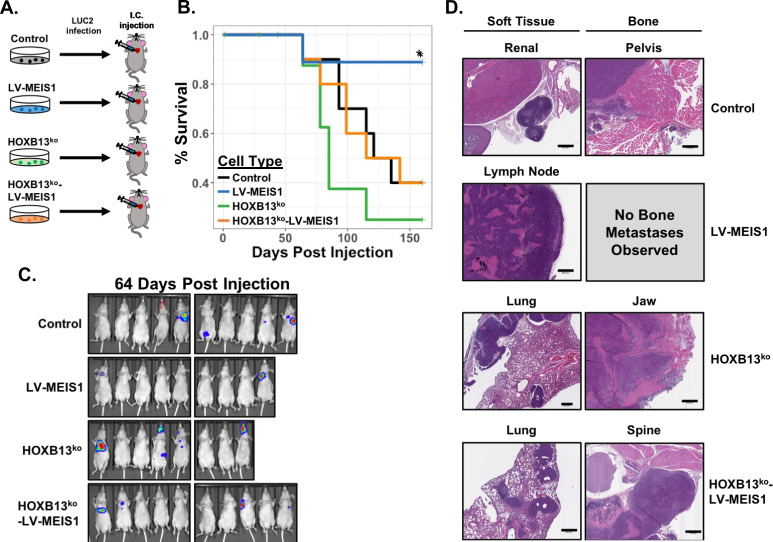
MEIS-mediated metastasis suppression in vivo is HOXB13-dependent.(A) Schematic of experimental design for intracardiac injection of CWR22Rv1 cell line derivatives into athymic nude mice to model metastasis. Control (black), LV-MEIS1 (blue), HOXB13ko (green), and HOXB13ko-LV-MEIS1 (orange) derivatives of CWR22Rv1 were each infected with a lentiviral LUC2 expression vector to enable in vivo bioluminescent monitoring of metastasis formation. LUC2-expressing cells were then injected into the left ventricle of athymic nude mice with 1 cell line per mouse (n = 10 mice per cell line). (B) Kaplan-Meier survival curves illustrating overall survival of mice post-intracardiac injection to the veterinarian-approved endpoint. LV-MEIS1 vs. control cells (Chisq = 4.1 on 1 degree of freedom, p=0.04); LV-MEIS1 vs. HOXB13ko-LV-MEIS1 cells (Chisq = 4.1 on 1 degree of freedom, p=0.04); LV-MEIS1 vs. HOXB13ko cells (Chisq = 6.1 on 1 degree of freedom, p=0.01); HOXB13ko vs. control cells (Chisq = 1.4 on 1 degree of freedom, p=0.2); HOXB13ko vs. HOXB13ko-LV-MEIS1 cells (Chisq = 0.9 on 1 degree of freedom, p=0.3); HOXB13ko-LV-MEIS1 vs. control cells (Chisq = 0 on 1 degree of freedom, p=1). (C) Representative images of in vivo bioluminescent imaging of the metastatic colonization of CWR22Rv1 intracardiac-injected mice. Red dashed circle in the control mouse image indicates location of a visually evident and palpable metastasis that did not produce bioluminescent signal. (D) Representative H and E images (20 × magnification) of histological sections of metastases from injected mice. Scale bars indicate 500 µm.